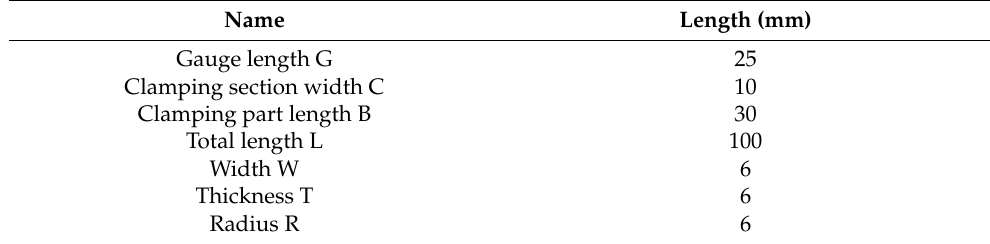
( b ) Figure 4. Schematic diagram of sample printing: ( a ) printing direction; ( b ) finished product. The coding of the sample in Figure 4 indicates the plane on which the largest surface of the sample is located. For example, the largest surface of the vertically printed sample is in the ZX plane in Figure 4; hence, ZX is used to represent vertical printing. There was a difference between vertical and flat printing. When the vertically printed sample was stressed, the bonding of each layer of the printed surface was relatively weak, which affected the tensile properties. For the flat-printed style, the performance in this direction was best since the direction of the tensile test was the direction of the scanning path and stretched along the grain. Side-printed samples also performed better in tensile tests than those printed vertically. However, the side-printed samples did not stretch ac- cording to the scanning path during the tensile test; hence, the mechanical properties were weak. In general, the mechanical properties of the flat-printed samples should be the strongest, and the vertical-printed samples should be the weakest. The parameters of 316L stainless-steel material are shown in Table 2, and the sample printing process parameters are shown in Table 3.